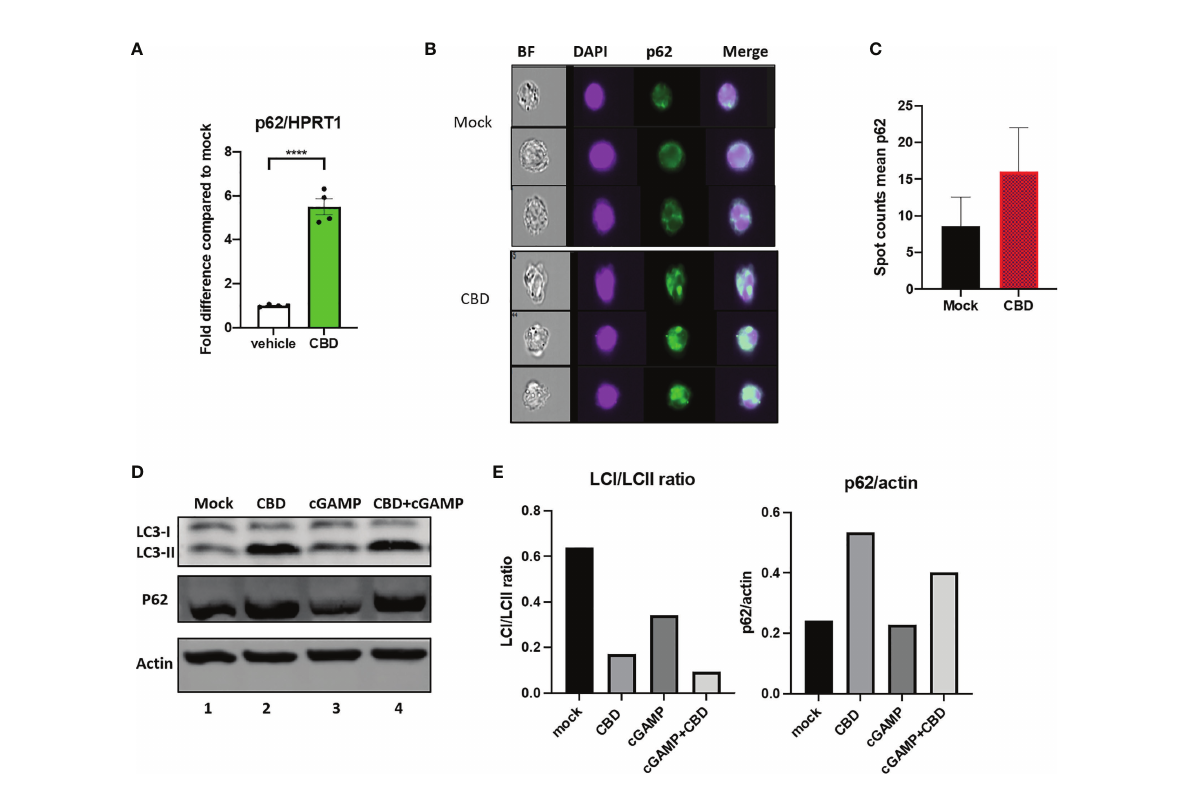
FIGURE 3 Cannabidiol treatment leads to increased autophagy activity. (A) Real time PCR analysis of p62 expression in THP-1 cells treated with either vehicle or CBD for 8 hours. (B) THP1 cells were treated with CBD overnight, fi xed and stained with DAPI, anti-p62 and analyzed by ImageStream. (C) Bar graph showing mean Spot count of p62 for mock and CBD treated THP1 analyzed by ImageStream IDEA software. (D) Western blot of THP1 cells treated with DMSO, CBD, cGAMP or CBD+cGAMP overnight. (E) Bar graph showing LCI/LCII ratio and p62/actin of the western blot analyzed by Image Lab Software.